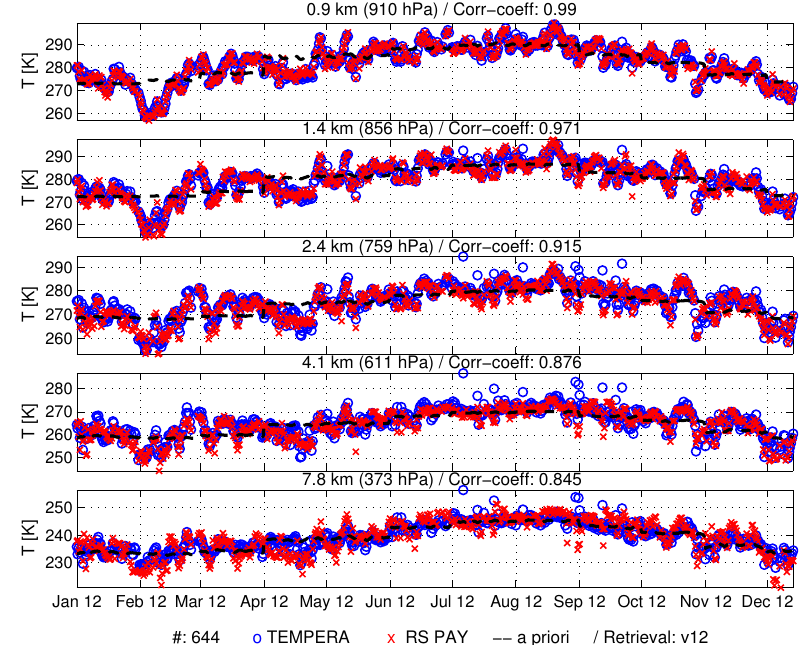
Fig. 11. Time series from 1 January to 13 December 2012 (644 profiles) of tropospheric temperature profiles from TEMPERA (blue) compared with radiosonde data from Payerne (red, regridded to TEMPERA grid) for five different altitude levels. The black dashed line is the a-priori.